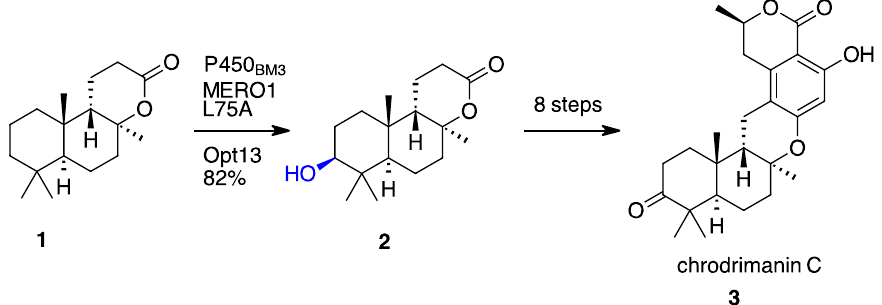
Scheme 1. Selective chemoenzymatic hydroxylation towards the synthesis of chrodrimanin C ( 3 )